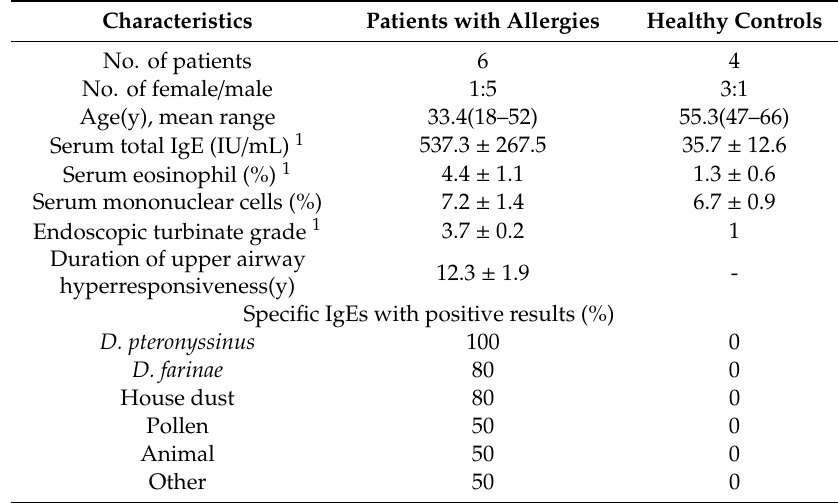
Table 4. Characteristics of patients with allergies and healthy controls participating in the